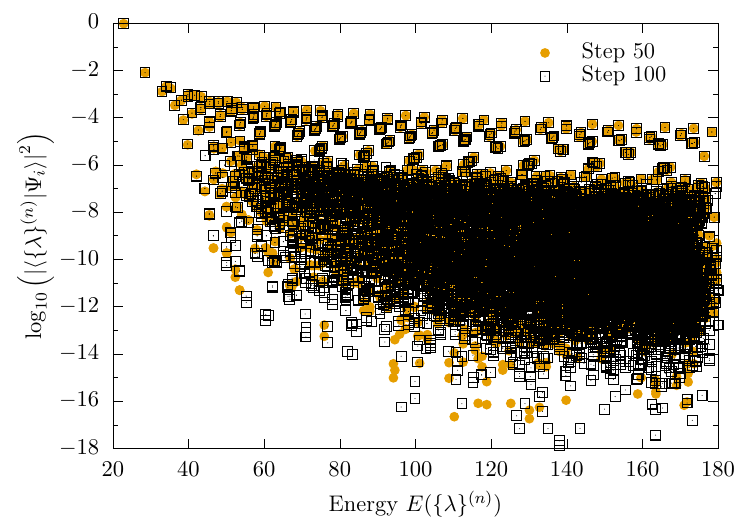
〉 between the ground state of the Lieb-Liniger model Figure 5: The overlaps 〈{ λ } ( n ) | Ψ i = 20 and eigenstates |{ λ } ( n ) 〉 of the c = 10 Lieb-Liniger model with energy with c i f 〉 is constructed in terms of the NRG-ME procedure, E ( { λ } ( n ) ) . The ground state | Ψ i and we present results after 50 and 100 steps, showing that the dominant overlaps are well-converged. This is not surprising in light of Fig.